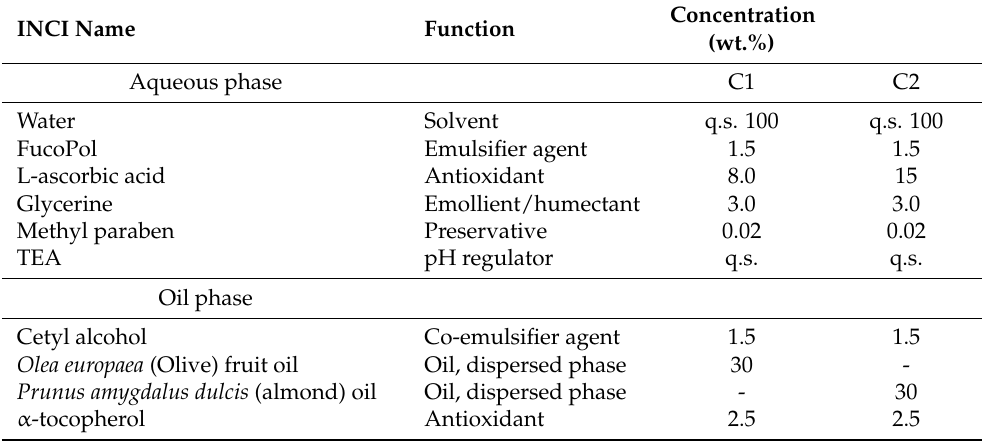
Table 1. Cosmetic formulation composition (wt.%). q.s.—quantity